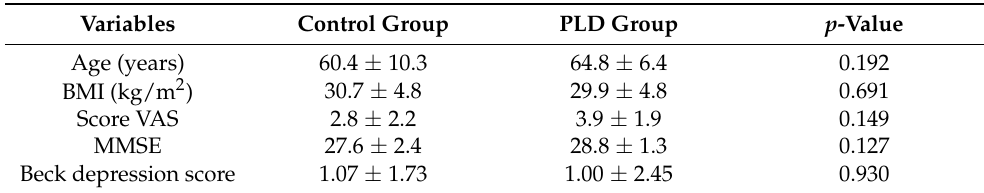
Table 1. Characteristics of patients included in the control and experimental groups and inter group comparisons assessed with independent Student t –test.